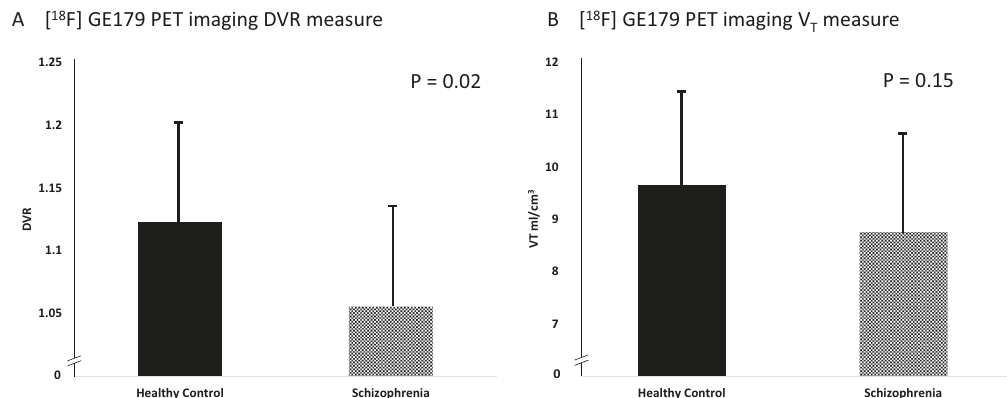
Fig. 1 [ 18 F]GE-179 DVR and V T hippocampus. NMDAR availability measured by positron emission tomographic (PET) imaging was signi fi cantly lower in the hippocampus in patients with fi rst-episode psychosis when DVR was measured ( A ) but not when V T was measured ( B ). Data are expressed as mean (SD) of the distribution volume ratio (DVR) ( A ) and distribution volume ( V T ) ( B ) of [ 18 F]GE-179.